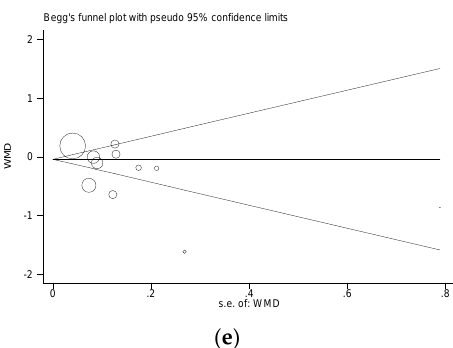
Figure 7. Publication bias funnel plots. Tests for publication bias of effects of buckwheat intake on ( a ) glucose, ( b ) total cholesterol ( c ) LDL cholesterol, ( d ) HDL cholesterol and ( e ) triglycerides. The funnel lines represent pseudo-95% confidence intervals; the size of the circles represent the weight of each study in the analysis. p -values (>0.05 for each plot) were derived from quantitative assessment of publication bias by Begg’s test and Egger’s test.